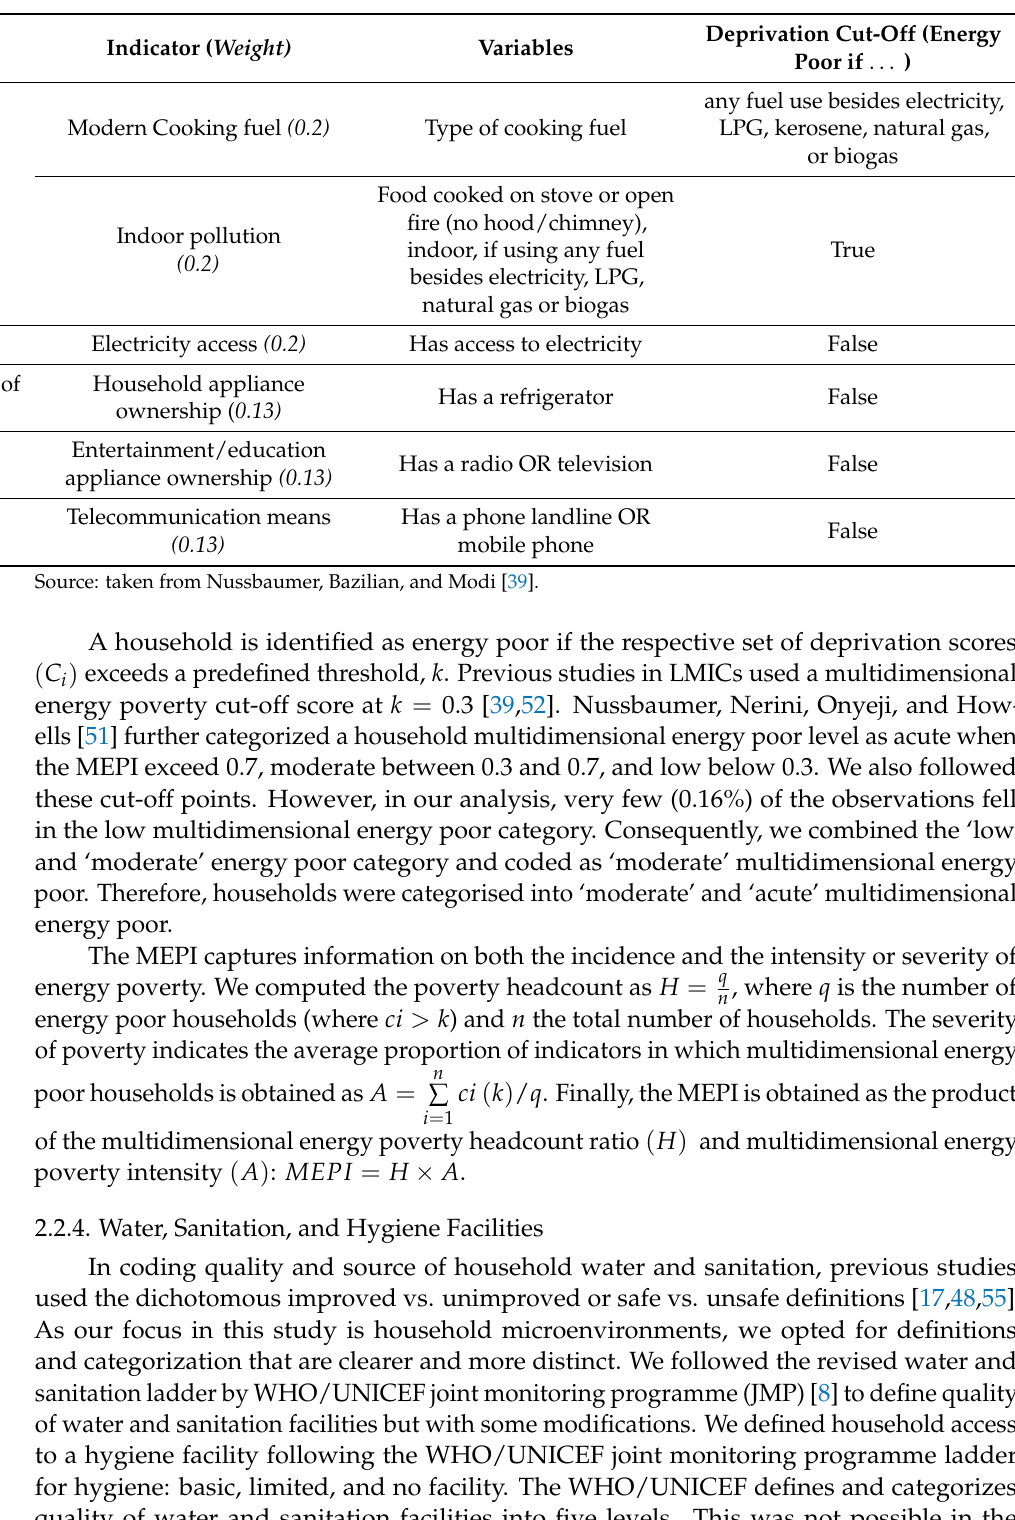
Table 1. Multidimensional energy poverty dimensions and respective variables with cut-offs, includ- ing relative weights (in